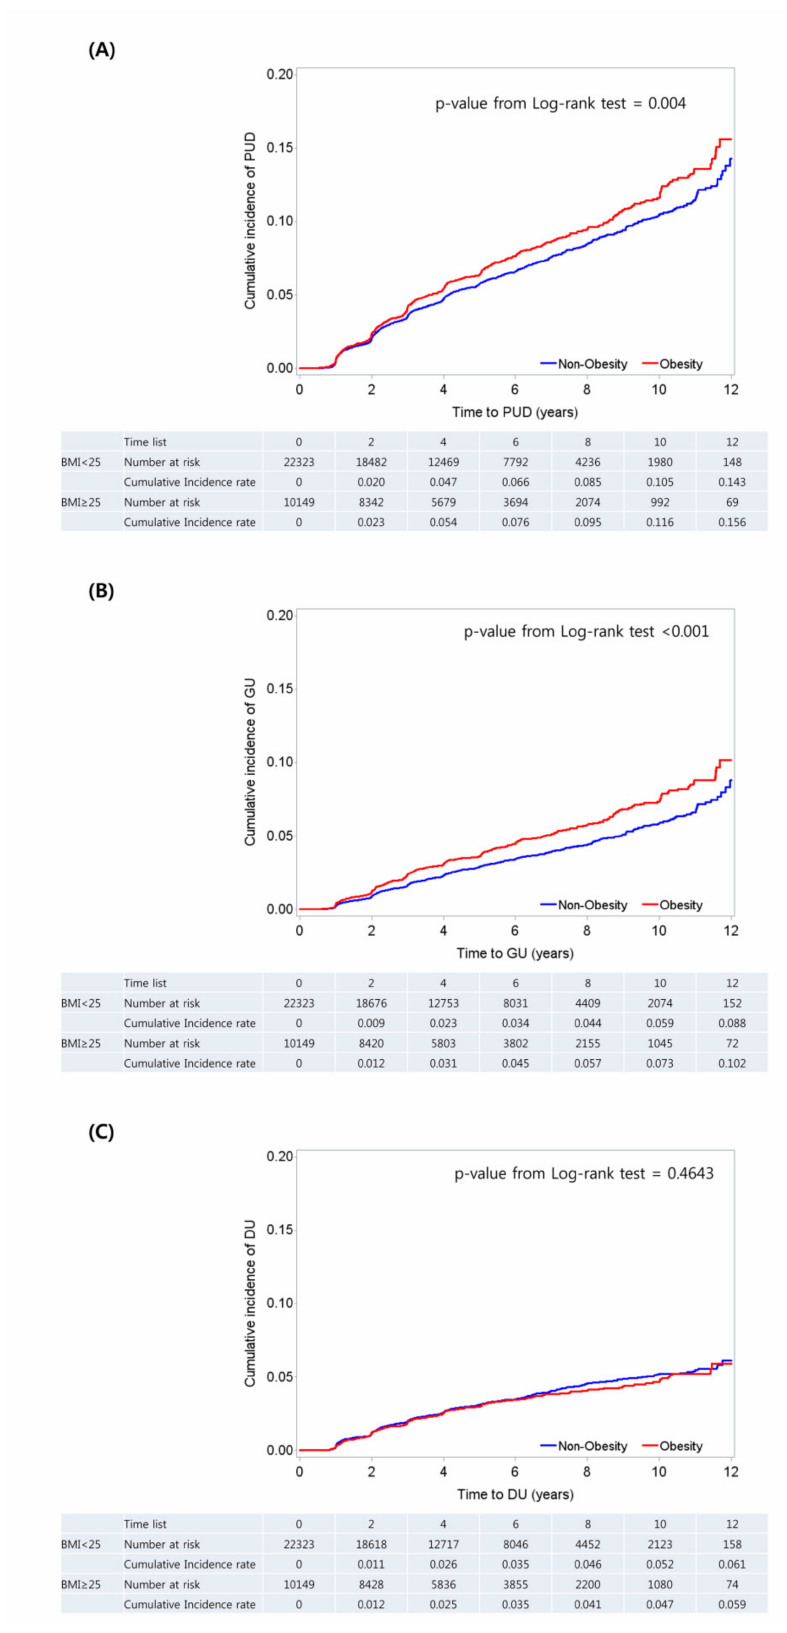
Figure 1. Cumulative incidence of peptic ulcer disease ( A ), gastric ulcer ( B ), and duodenal ulcer ( C ) by obesity